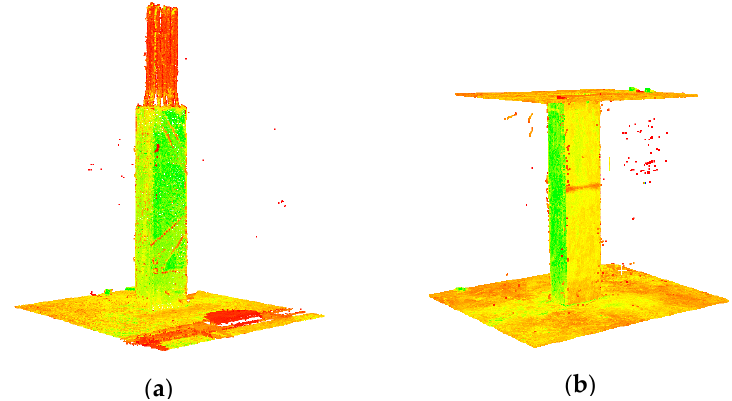
Figure 2. Typical point cloud of a rectangular column: ( a ) before top floor concreting; ( b ) after top floor concreting (colors represent intensity).